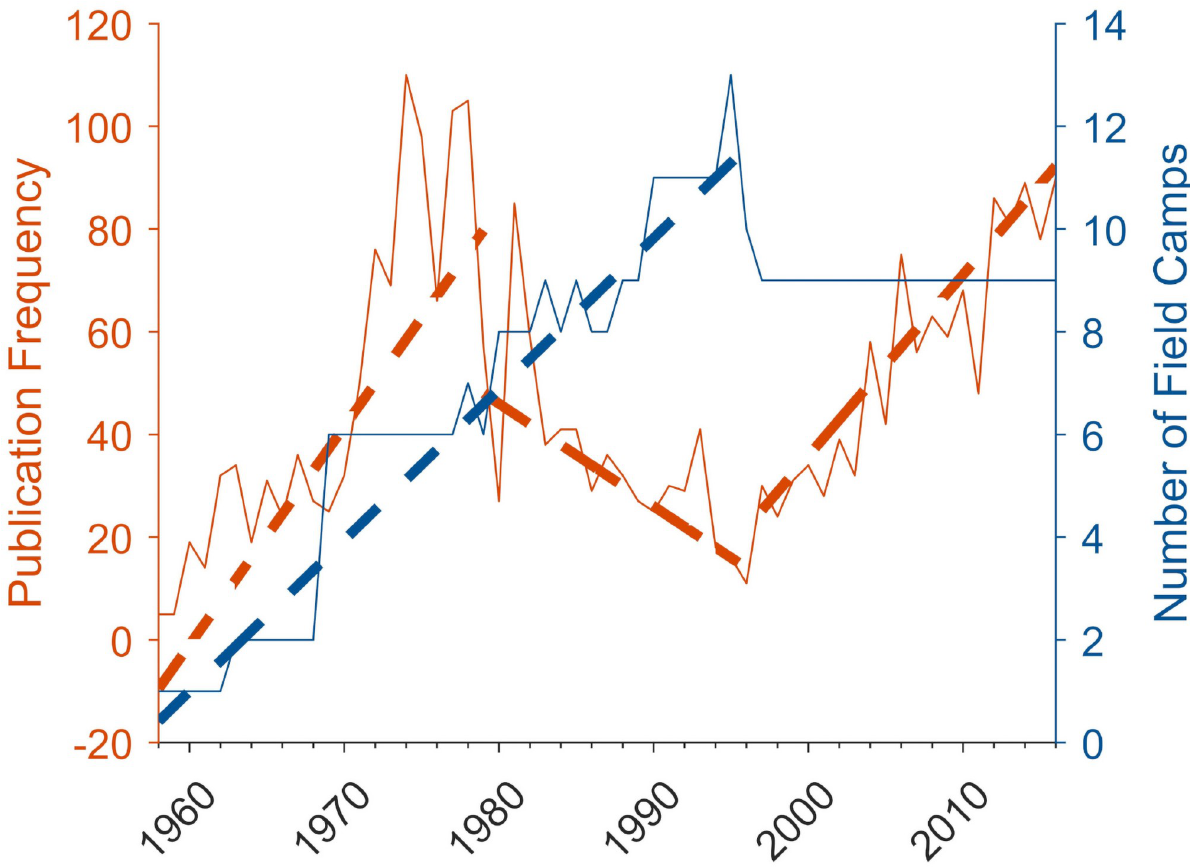
Fig 3. Number of publications and field camps by year since the construction of the first field camp in 1958. Dashed lines indicate statistically significant Sen’s slopes between changepoints. For publication frequency, p-values from left to right are < 0.001, < 0.01, and < 0.001. For number of field camps, p <